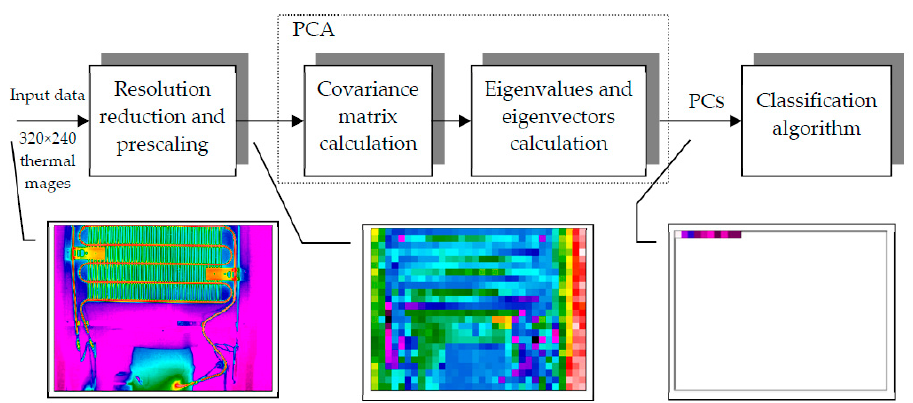
Figure 1. Block diagram of the quality control principal component analysis (PCA)-based algorithm and data at its successive steps. PCs: Principal components.